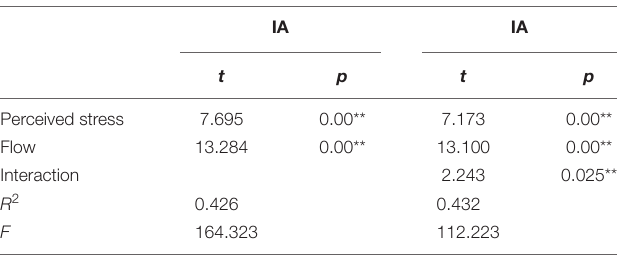
TABLE 4 | Regulating model test of flow.